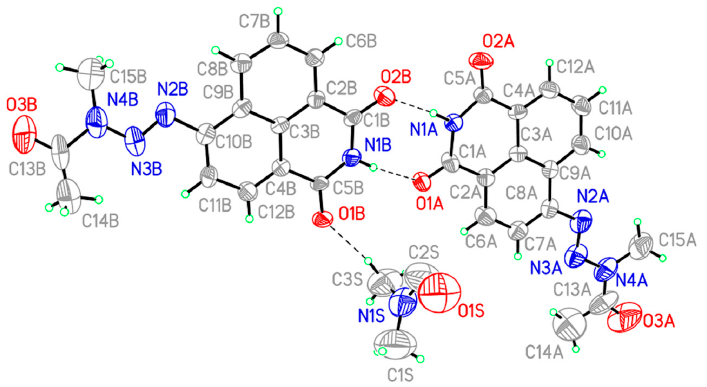
Figure 6. X-ray crystallographic structure of compound 9a . Non-hydrogen atoms drawn as ellipsoids at the 50% probability level and hydrogen atoms as circles of arbitrary radii.